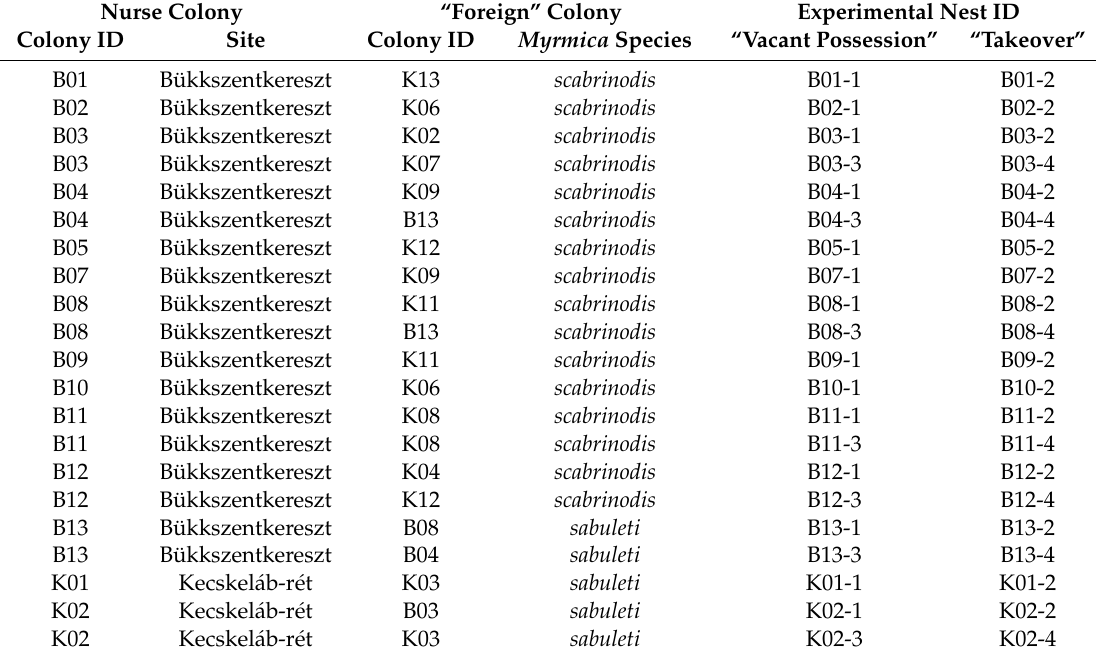
Table A1. Summary of the experimental nests used in the two experiments “Vacant possession” and “Takeover”. The same 40 combinations of “nurse” and “foreign” colonies were used for both experiments, with di ff erent P. alcon caterpillars and worker ants. The identity of the “foreign” Myrmica species is shown—the nurse colony was of the other species. See Table 1 for an explanation of colony IDs. Nurse Colony “Foreign” Colony Experimental Nest ID Colony ID Site Colony ID Myrmica Species “Vacant Possession” “Takeover”